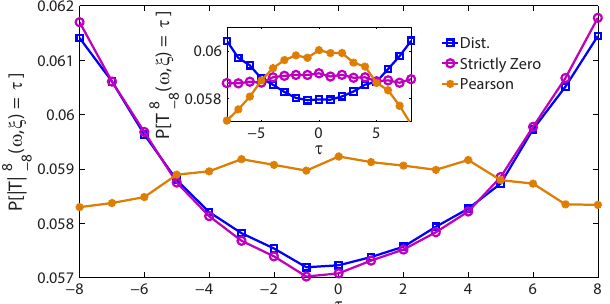
−8 −6 −4 −2 0 Figure 4. Probability distribution of | T | 8 − (ω(t),ξ(t)) and T 8 − (ω(t),ξ(t)) (in- Figure 3. Distribution of | T | 8 − 8 8 set) in the i.i.d. case for different CV ( σ/µ ) for the time series ω(t) . T 8 − (ω(t),ξ(t)) (inset) for various i.i.d. series, setting the 8 Both time series are Gaussian distributed, with ξ(t) drawn from a means to zero in different ways. For “Dist.” the time series ω(t) distribution with zero mean and unit variance, and ω(t) drawn from and ξ(t) are drawn from a normal distribution with zero mean; for a distribution with the displayed mean and standard deviation. This “Strictly Zero” the sample means ( ¯ ω , ¯ ξ ) are then removed from the means they are stationary and we can again write C(τ,t) = C(τ) . corresponding series; for “Pearson” the sample means and standard We can see that where the CV of ω(t) are the same the curves are deviations are calculated over the (cid:127) points that enter into the identical irrespective of their different means ( µ ) and standard devi- calculation for each τ , and then their means are removed and the ations ( σ ). This shows that it is the only quantity affecting the bias series are divided by their standard deviations. Fixed parameters for Gaussian variables. Fixed parameters are: (cid:127) = 64, with N = 2 21 are: (cid:127) = 16, with N = 2 23 realizations.